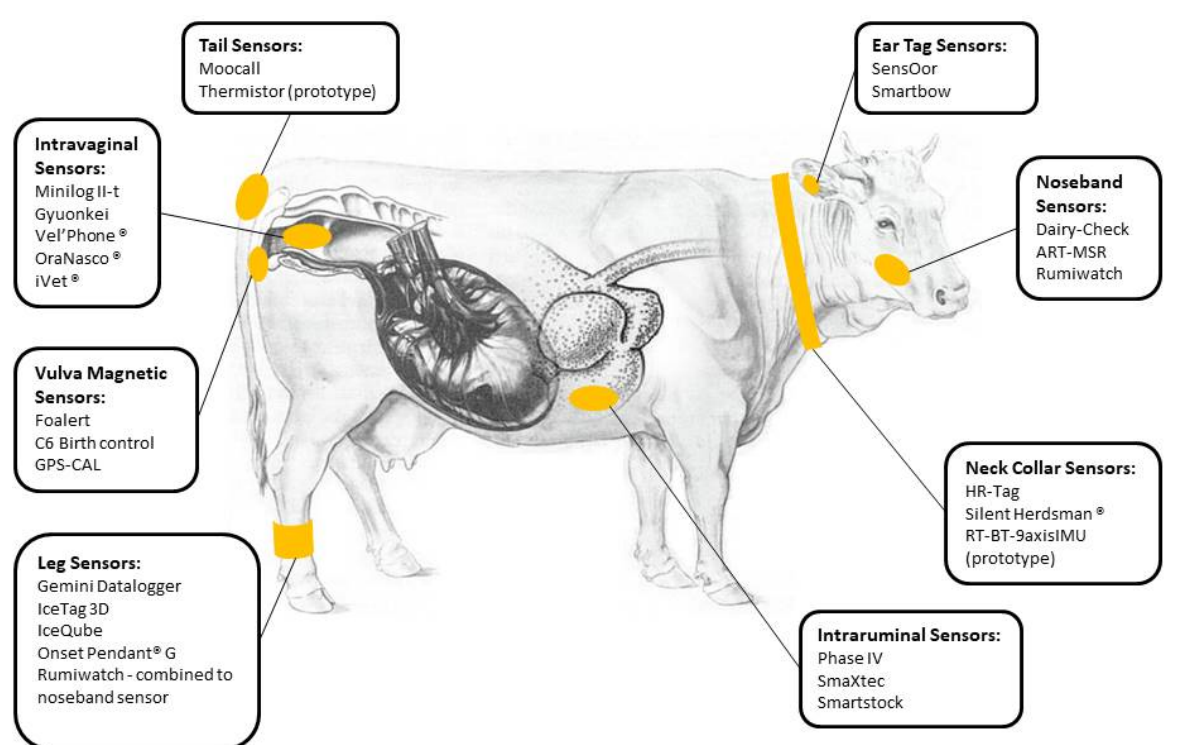
Figure 1. Application of available devices for calving prediction in cattle. Modified from: Richter and Götze (1978), Fig. 100, pp 142 [22].